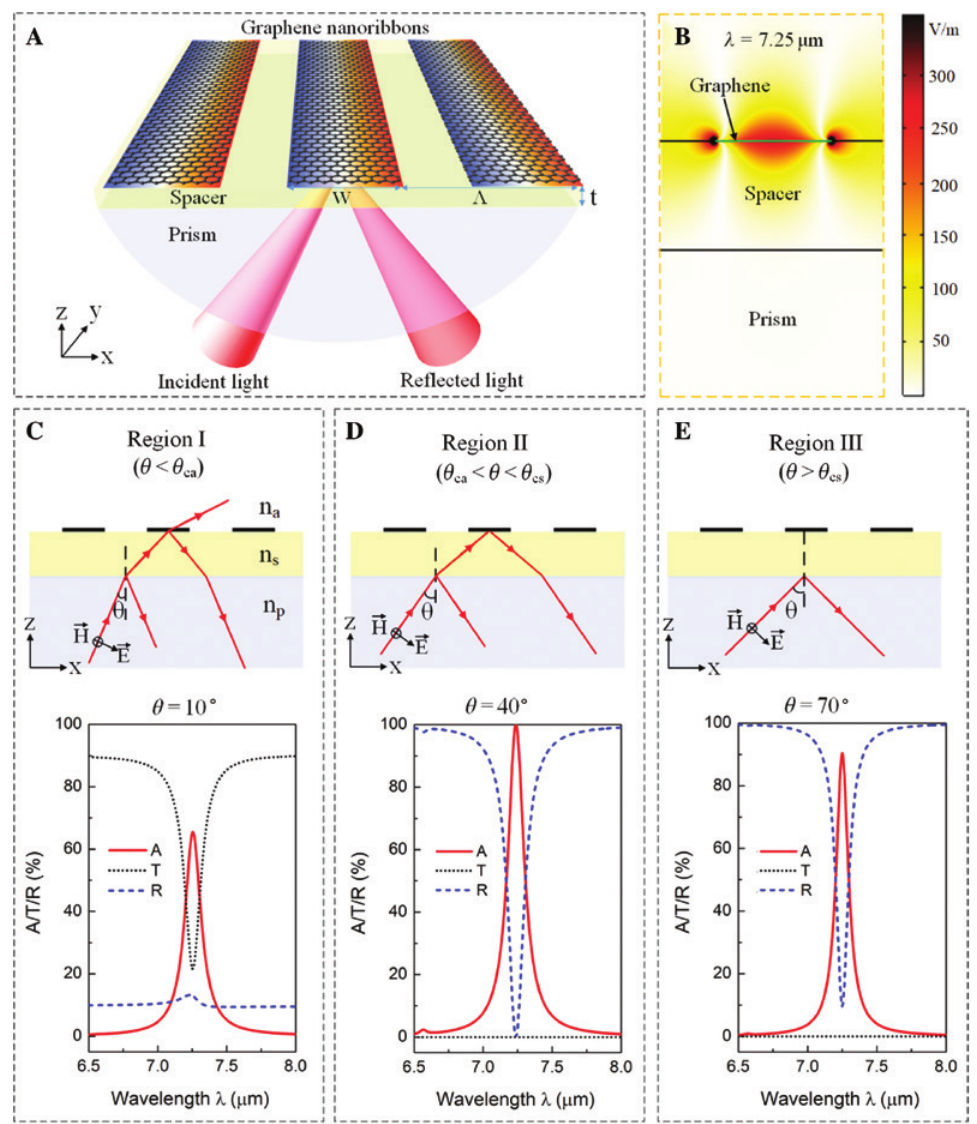
Figure 1: The physical processes of graphene plasmon excitations using Otto configuration. (A) Schematic of the structure consisting of patterned graphene nanoribbons on a prism separated by a spacer layer. (B) Electric field | E the mode at the resonant wavelength. Absorption, transmission, and reflection spectra of the structure for the cases (C) I, (D) II, and (E) III, when the incident angle is 10 ° , 40 ° , and 70 ° , respectively. The inset shows the cross-section of the